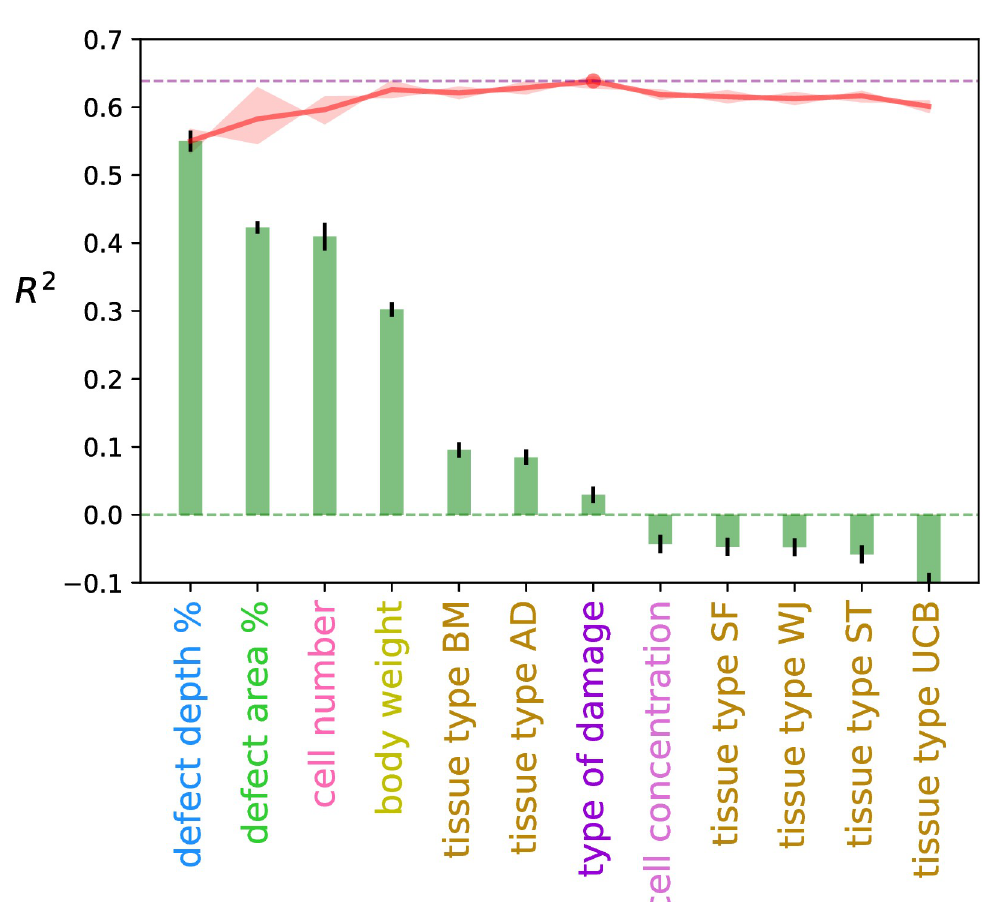
Fig 3. Accuracy of the neural network. R 2 values of the neural network model trained with individual property (bar) and the combination of best performing individual properties (red line). The shaded red area represents the uncertainty of each R 2